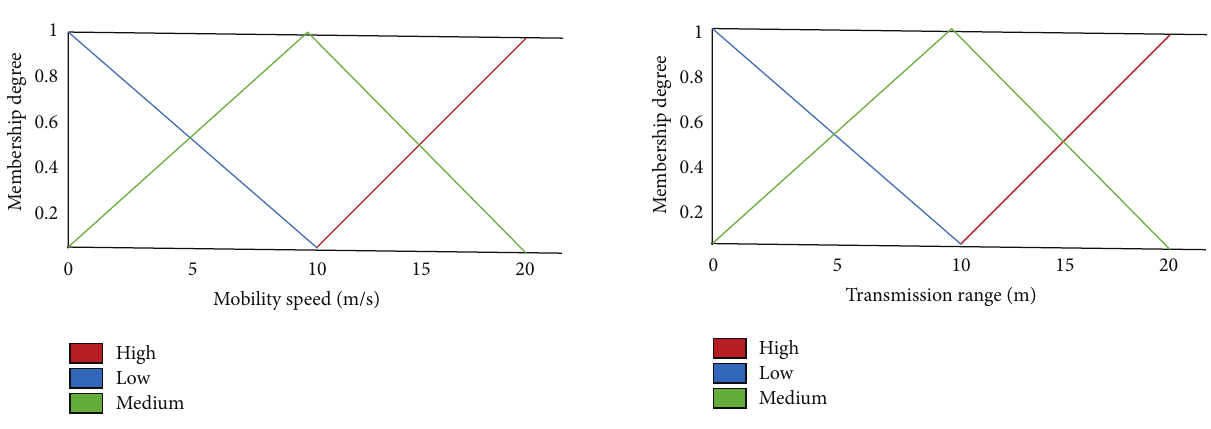
Figure 2: Fuzzy set for fuzzy input variable mobility speed.